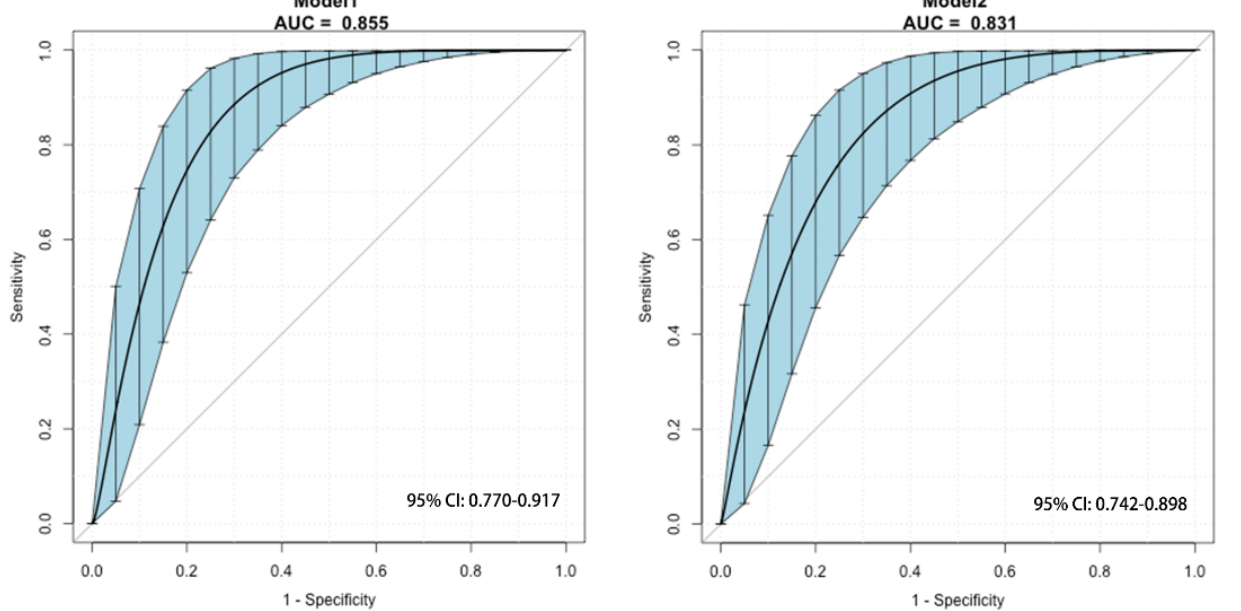
Figure 1. The ROC curve for the predictive model 1 and 2 using bootstrap resampling (times = 500). Shading shows the bootstrap estimated 95% CI with the AUC. ROC, receiver operating characteristic; AUC, area under the curve; CI, confidence interval.